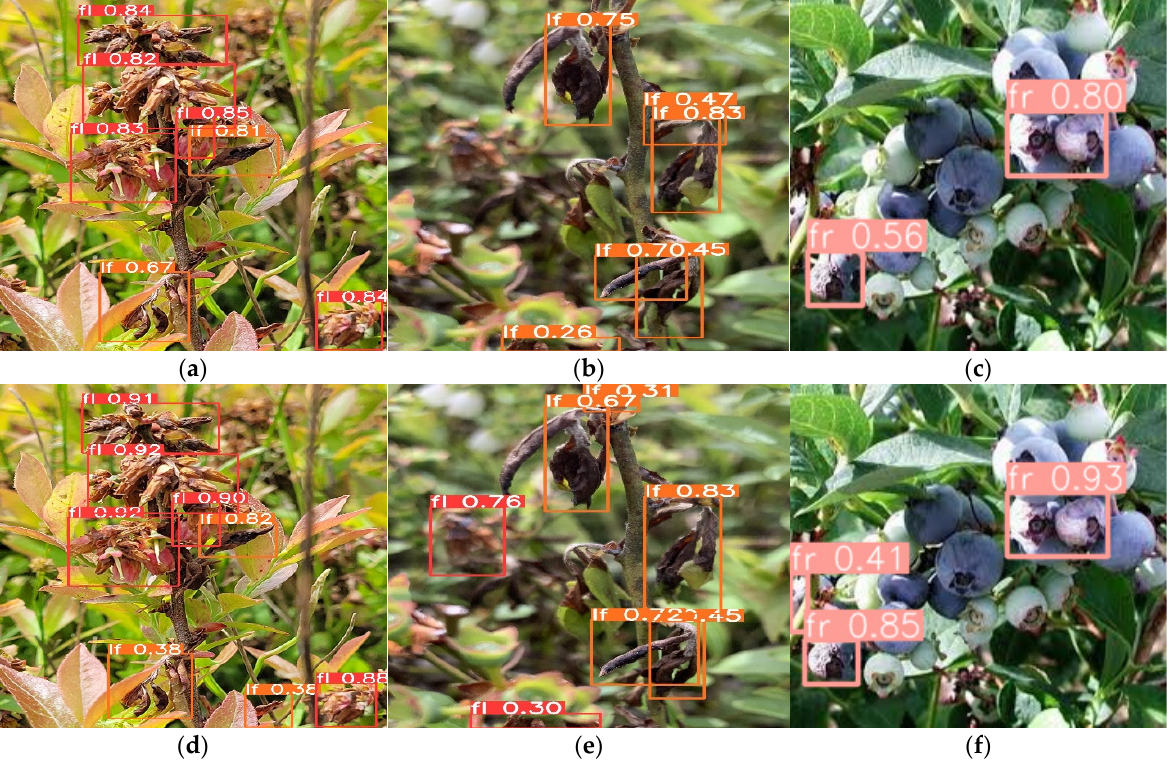
Figure 8. Comparison of detection results focused on the plant stem.Yolov5s ( a – c ) and Yolov5s-CA ( d – f ).